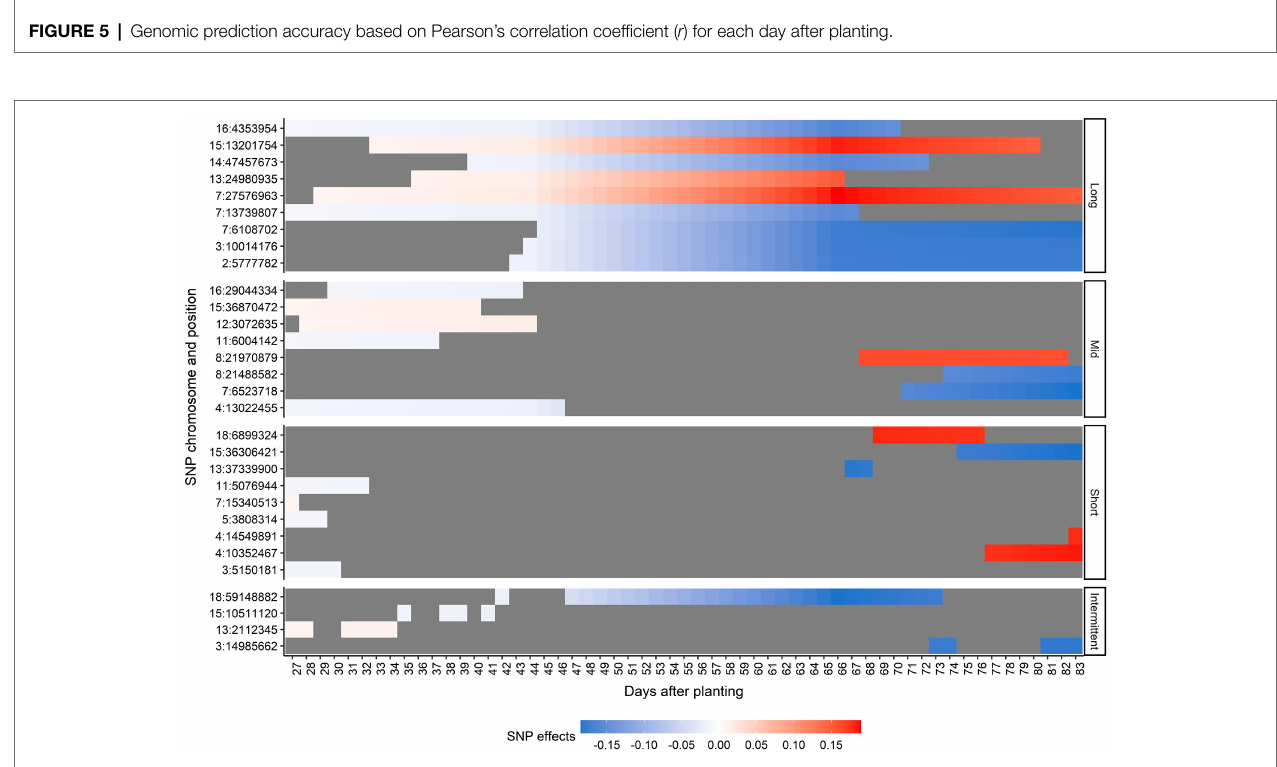
FIGURE 6 | Effects for the selected single-nucleotide polymorphisms (SNPs) across days after planting, in each duration category. Duration categories were defined as long-duration (SNPs present for more than 30 consecutive days), mid-duration (SNPs present for more than 10 consecutive days but less than 30), short-duration (SNPs present for less than 10 consecutive days), and intermittent (SNPs at different non-consecutive intervals). Each y-axis point corresponds to one SNP represented by the chromosome number and position in the soybean Williams 82 reference genome (Wm82.a2.v1; Diers et al., 2018). The blue scale represents negative effects and the red scale represents positive effects. The gray color indicates a zero